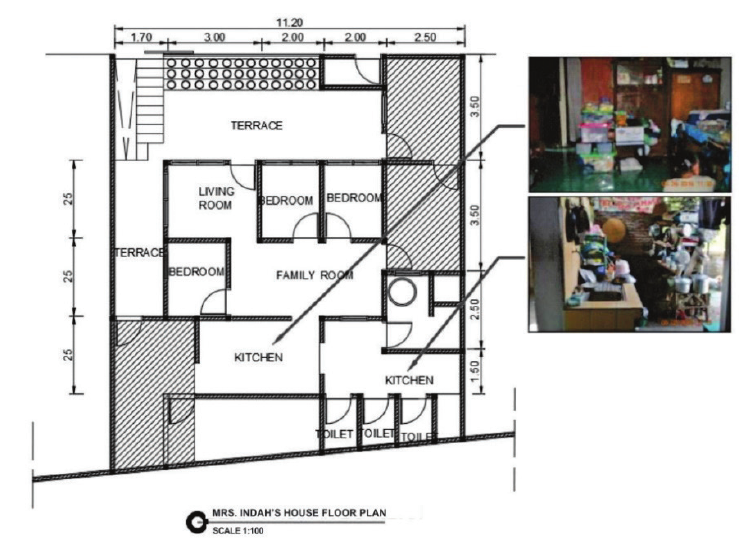
Figure 7. Mix-use space is in the kitchen and family room in Mrs. Indah house (Case